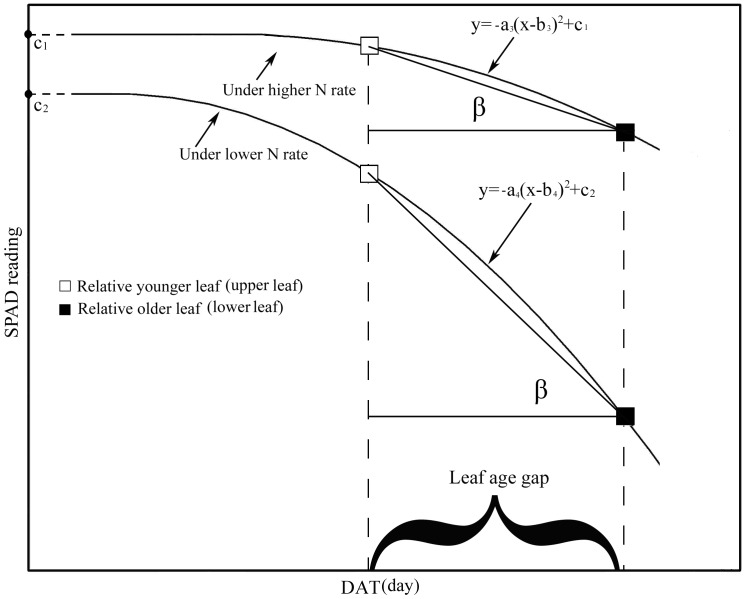
Temporal dynamics of SPAD readings over leaf lifespan under higher and lower N rates fitted to a piecewise function during leaf growth and senescence stages.Dynamics of upper and lower leaves were assumed to follow the same trajectory (piecewise function).